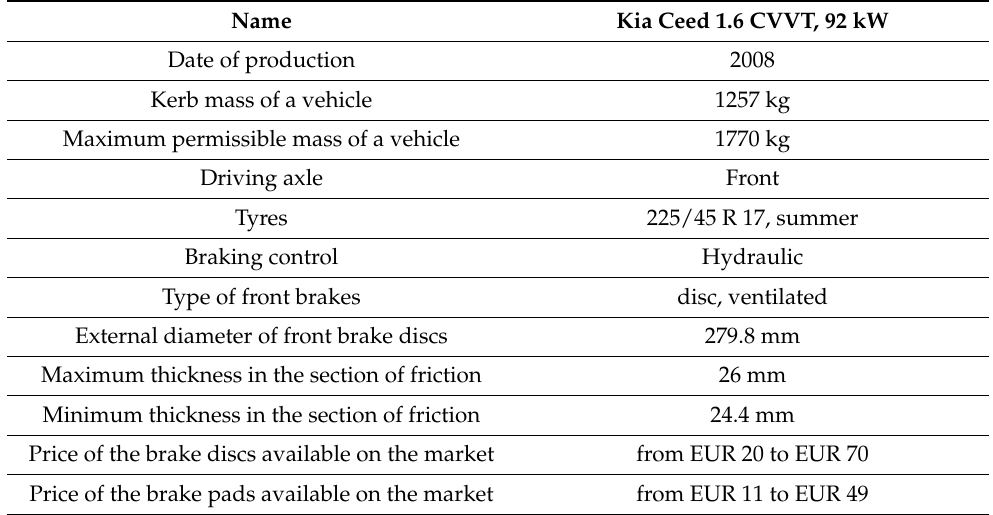
Table 1. Technical parameters of Kia Ceed